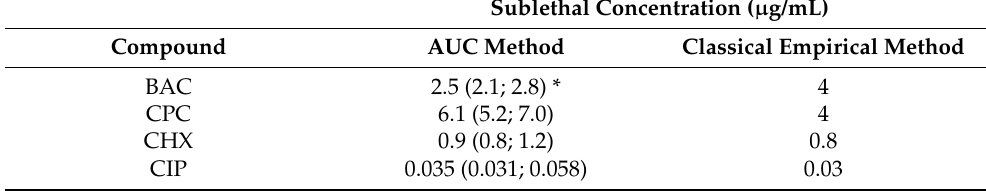
Table 2. Sublethal single concentrations derived and used for further combination experiments on all compounds tested, as determined by applying the newly introduced area under the curve (AUC) and classical empirical methods (Figure